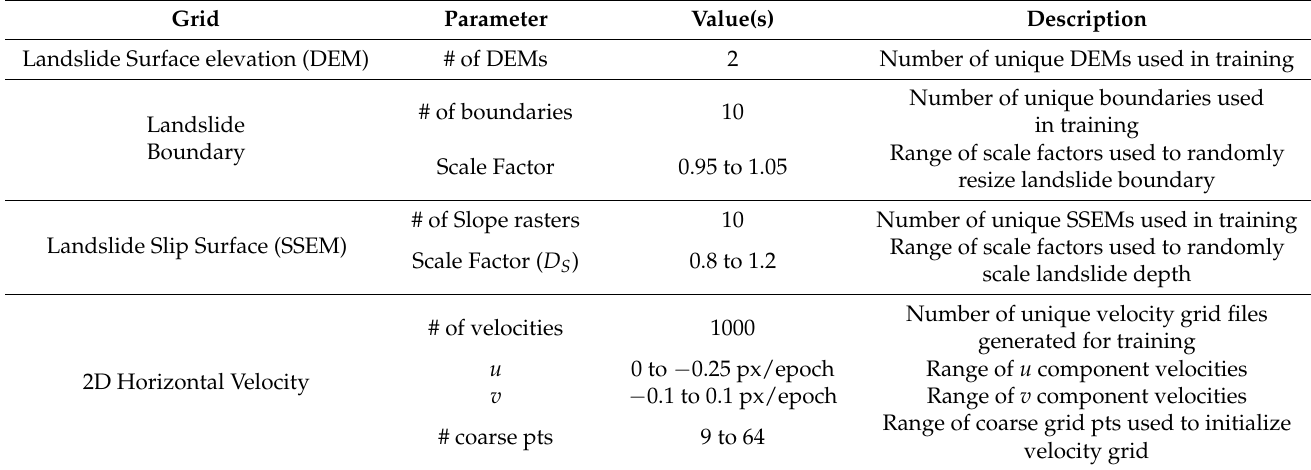
Table 1. Parameters used to generate training data for each of the input finite